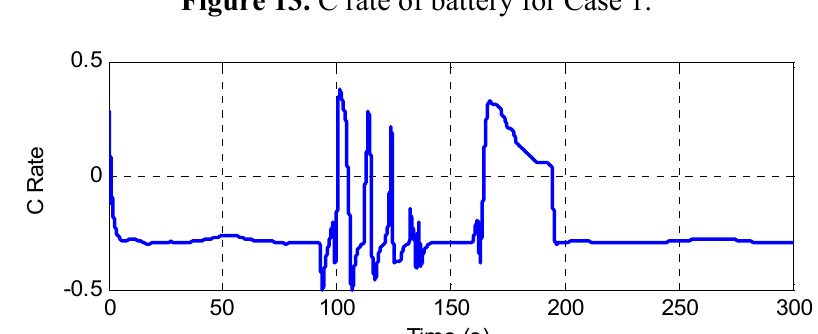
Figure 13. C rate of battery for Case